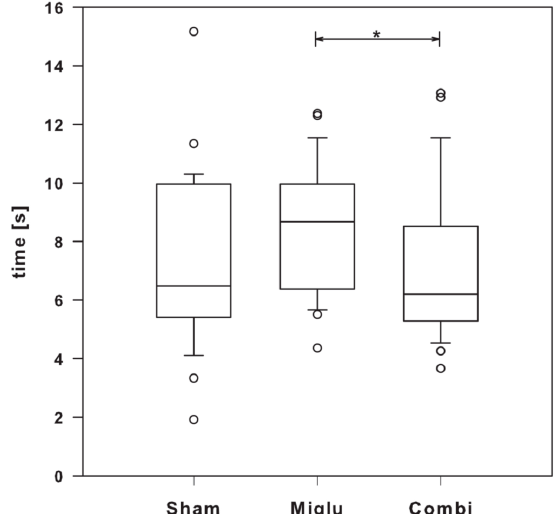
Figure 6. Hot-plate test. Significant differences in pain sensitivity were seen between miglu- and combi-groups ( n sham = 29, n miglu = 26, n combi = 26). However, none of the treatment groups was significant different from the sham-group. Asterisks indicate significant differences between treatment groups after one way analysis of variance on ranks and Dunn’s all pairwise multiple comparison procedures (* p < 0.05 ). Box plot depicts the animal groups graphically by displaying the following descriptive statistical parameters: the median, the upper and lower quartiles, and outliers (circles) that lie outside the 10th and 90th percentiles (whiskers).